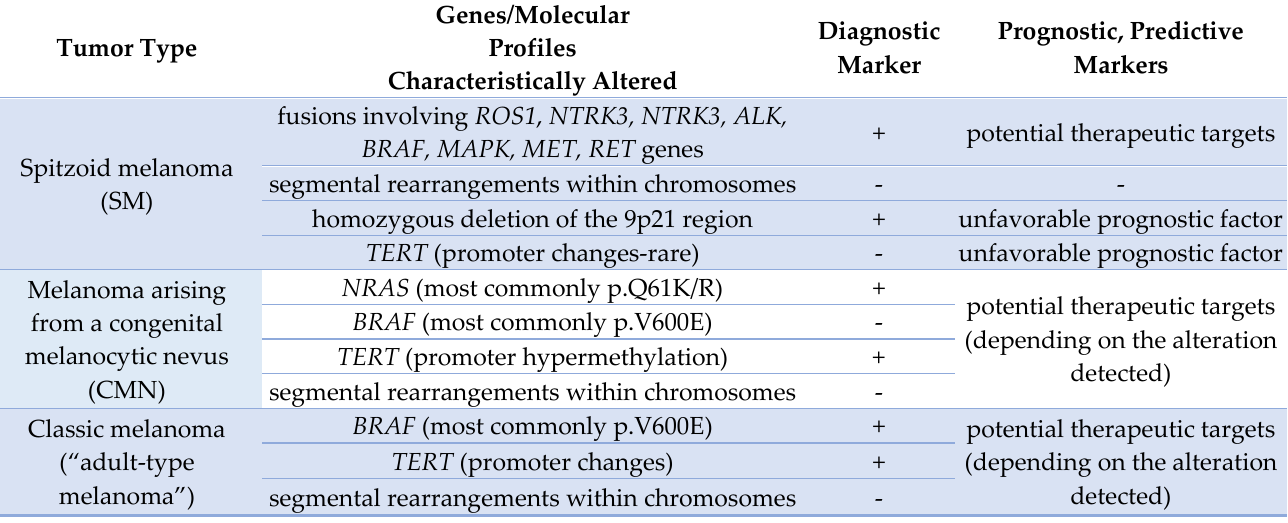
Table 8. Molecular markers—melanoma.